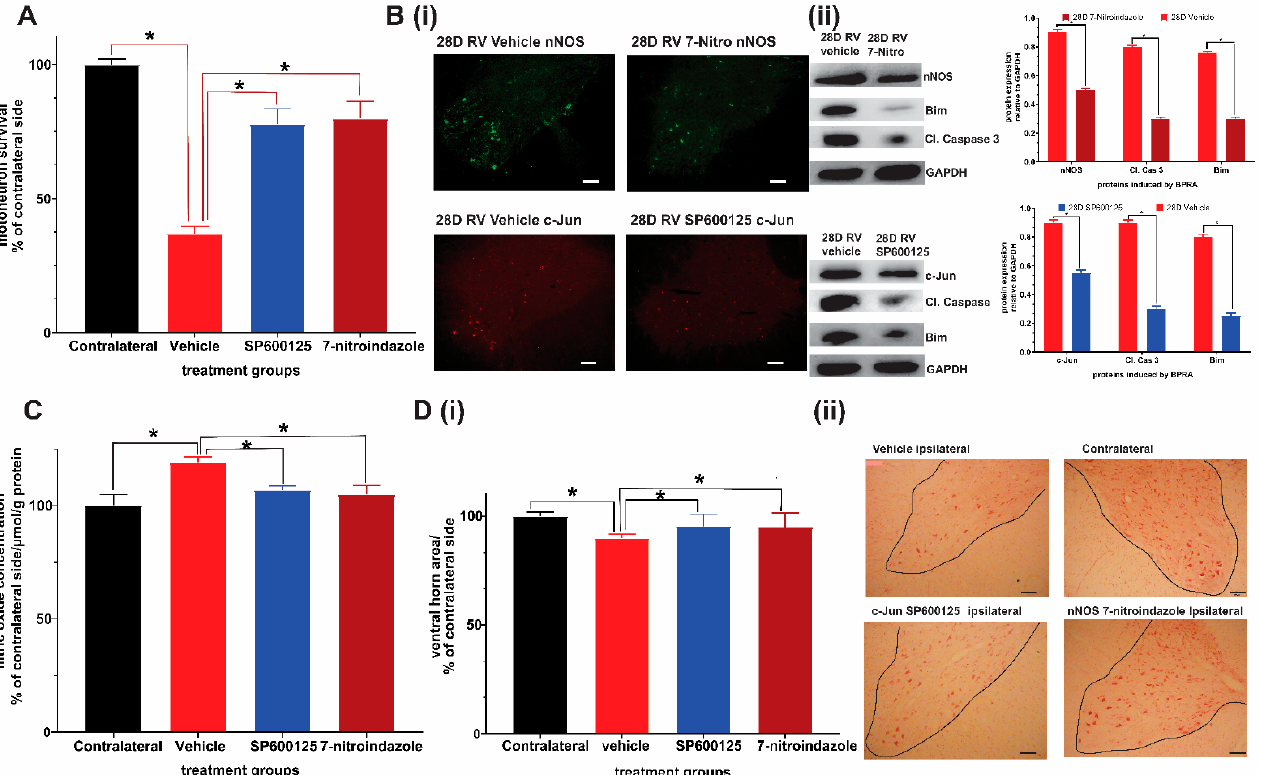
Figure 1. Neuroprotective effects of 28-day daily intraperitoneal injections of c-Jun/JNK inihibitor SP600125 and nNOS inihibitor 7-nitroindazole (7-nitro). ( A ) Comparison of ventral horn motor neuron survival at 28 days (1 month) after avulsion between the control and SP600125 or 7-nitroindazole treatment groups ( p < 0.05, n = 5/group). ( B ) Representative immunofluorescence shows that SP600125 and 7-nitroindazole treatment suppressed the expression of c-Jun and nNOS, respectively at 28 days after avulsion relative to vehicle treatment. Representative Western blots show that SP600125 and 7-nitroindazole treatment suppressed the expression of c-Jun and nNOS, respectively at 28 days after avulsion relative to vehicle treatment. Tissue lysates were obtained from ipsilateral ventral horns ( n = 5; p < 0.01). The neuroprotective treatments also suppressed apoptosis of motor neurons by inhibiting the overexpression of components of the mitochondrial pathway of apoptosis namely Bim, and cleaved caspase 3 compared to that observed in vehicle-treated control rats. ( C ) Treatment with SP600125 and 7-nitroindazole significantly reduced oxidative stress as indirectly measured by the total nitric oxide production compared with the controls. ( D ) The sizes of the corresponding ipsilateral/contralateral areas were computed by planimetry ( i ). There was significant atrophy of ipsilateral ventral horns of vehicle-treated rats relative to contralateral side ( ii ). Data expressed as Mean ± standard deviation (SD), as a percentage of values of the corresponding contralateral side. Comparisons by one-way analysis of variance (ANOVA) whereby * p < 0.05, n = 5 rats.